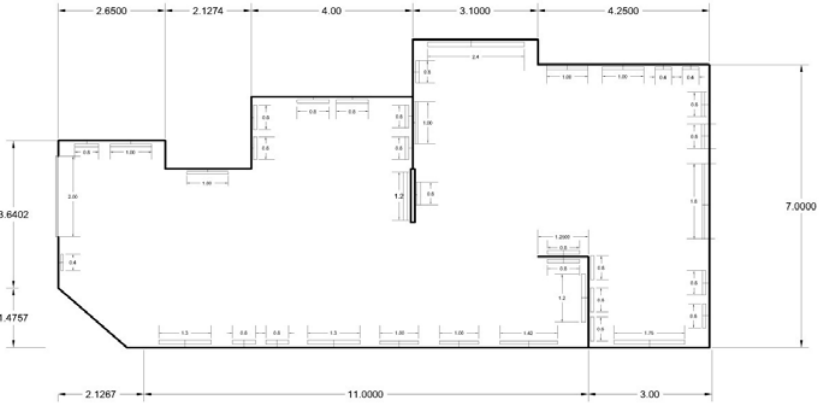
Figure 2. Plan of Picasso Exhibition in Cairo